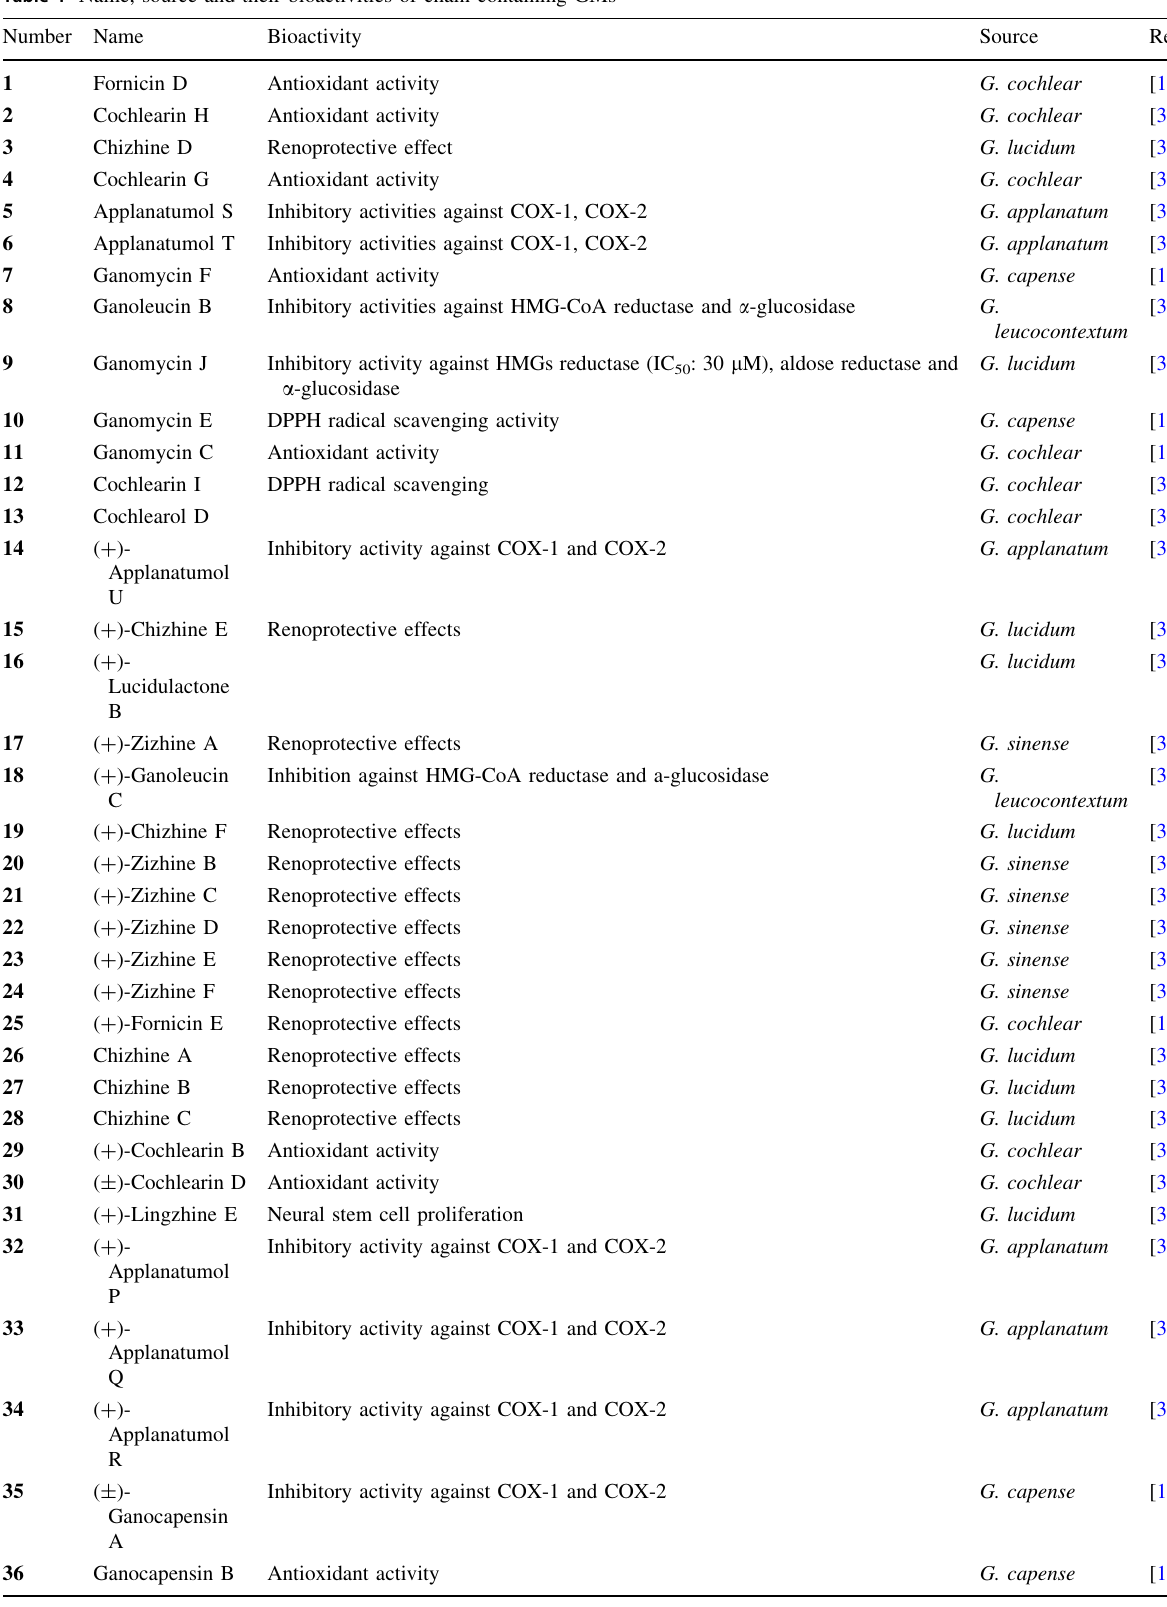
Table 1 Name, source and their bioactivities of chain-containing